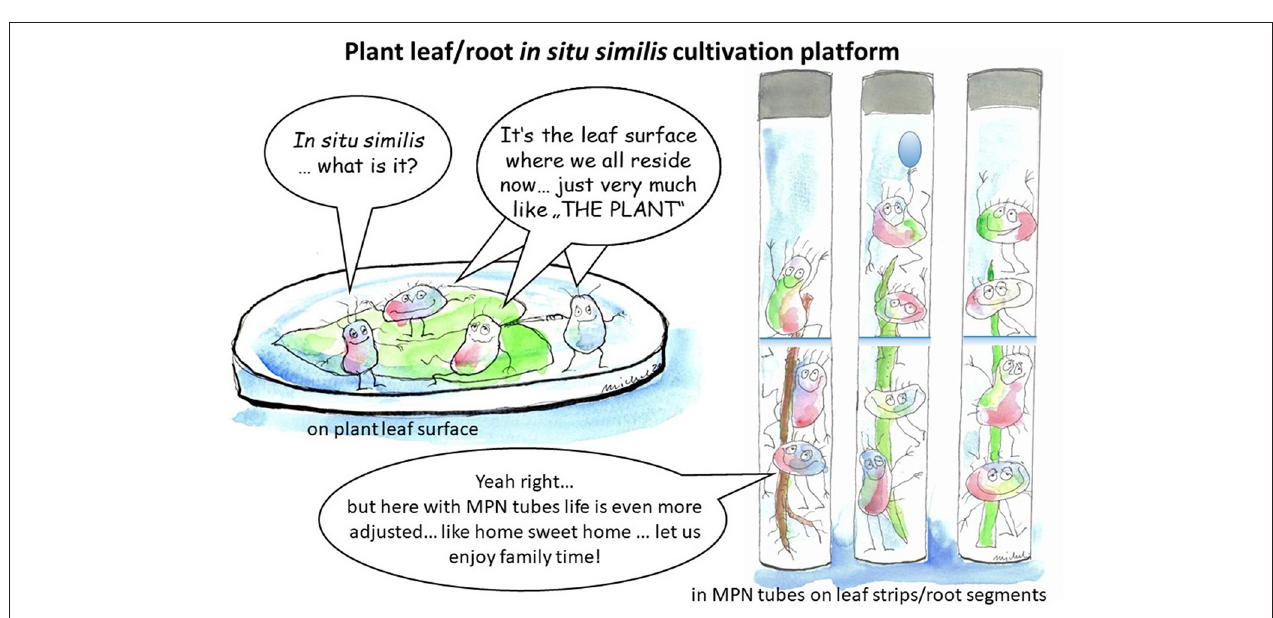
FIGURE 8 | Plant leaf/root in situ similis cultivation platform: On the left, direct inoculation on the top of leaf surfaces/pads placed in water agar plates; on the right, inoculation of leaf strips/root segments-based MPN culture tubes.